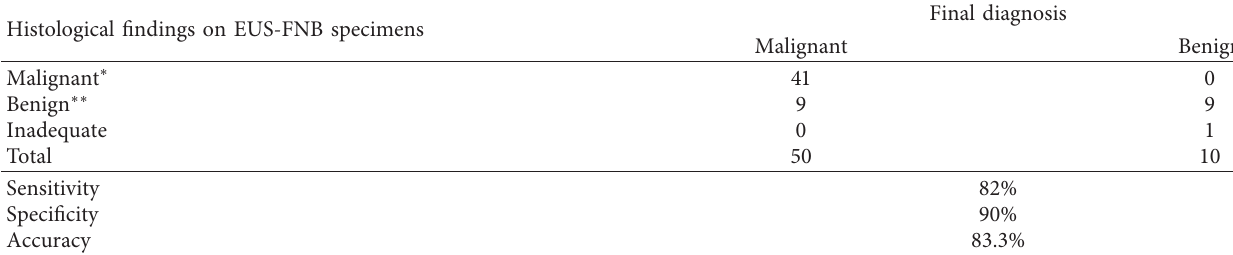
Table 2: Clinical outcomes of EUS-FNB.